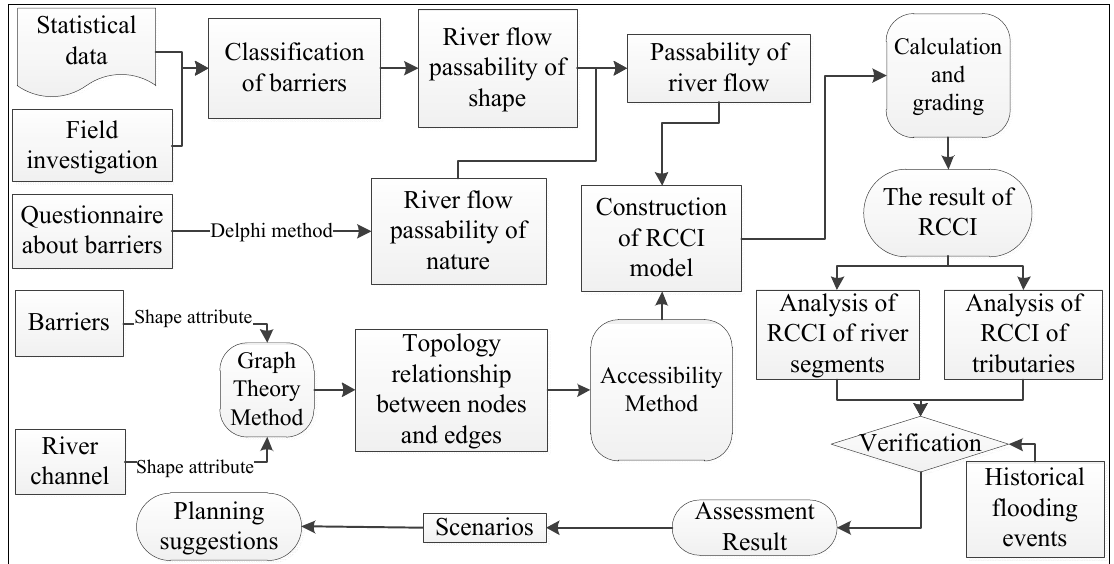
Figure 2. The technical flowchart of the river channel connectivity index (RCCI ) model.